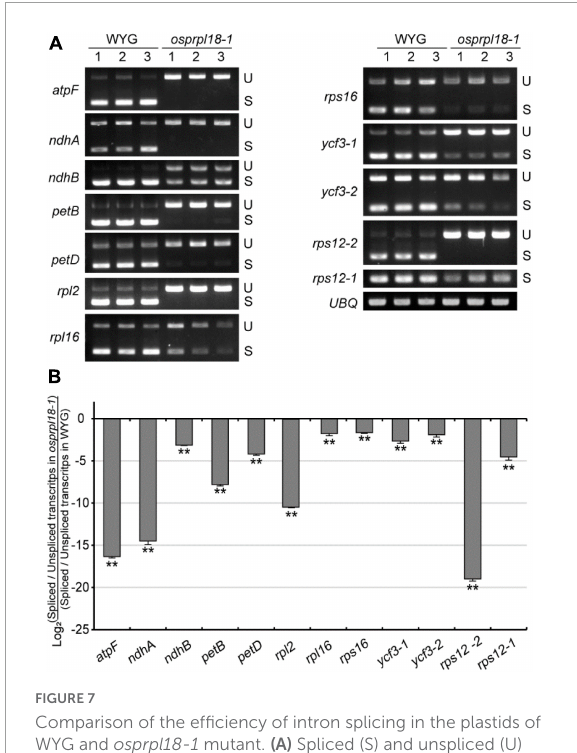
FIGURE7 Comparison of the efficiency of intron splicing in the plastids of WYG and osprpl18-1 mutant. (A) Spliced (S) and unspliced (U) transcripts examined by RT-PCR. (B) Relative quantitative analyses of plastid intron splicing efficiency of WYG and osprpl18-1 mutant by qRT-PCR. Data represent the mean log2 ratios of splicing efficiencies in osprpl18-1 mutant to the wild type (WYG). Three independent biological replicates were used for each genotype. The asterisks indicate significant difference between WYG and osprpl18-1 mutant (** P < 0.01; Student’s t